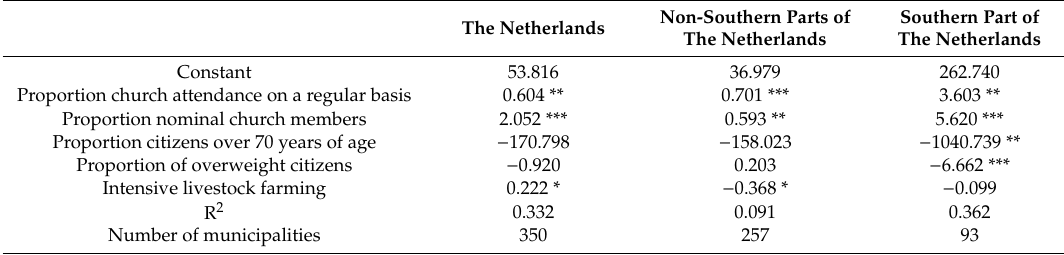
Table 2. Linear regression analyses (B’s) of hospitalized patients with COVID-19 per 100,000 residents (March 2–May